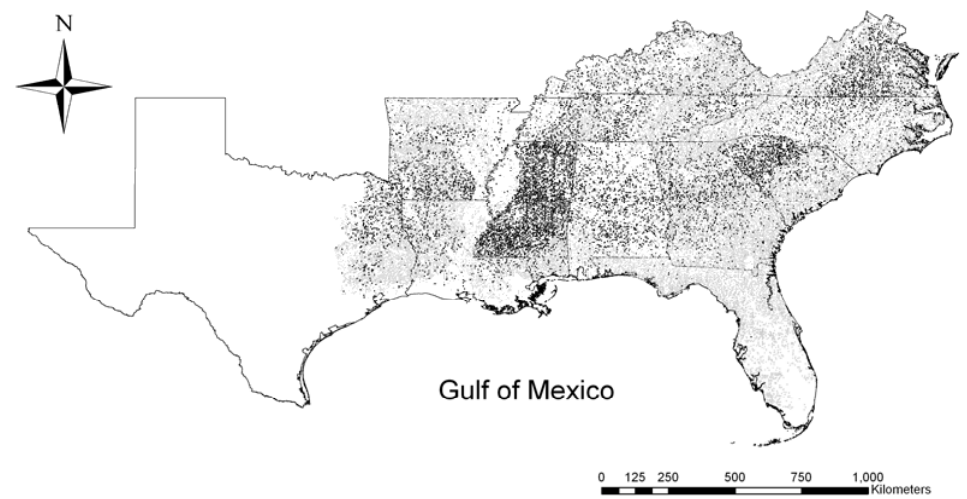
Figure 1. Current occupation of forestlands in the southern United States by L. japonica [42,43]. Gray and black dots represent absence and presence on U.S. Forest Service plots of Japanese honeysuckle,